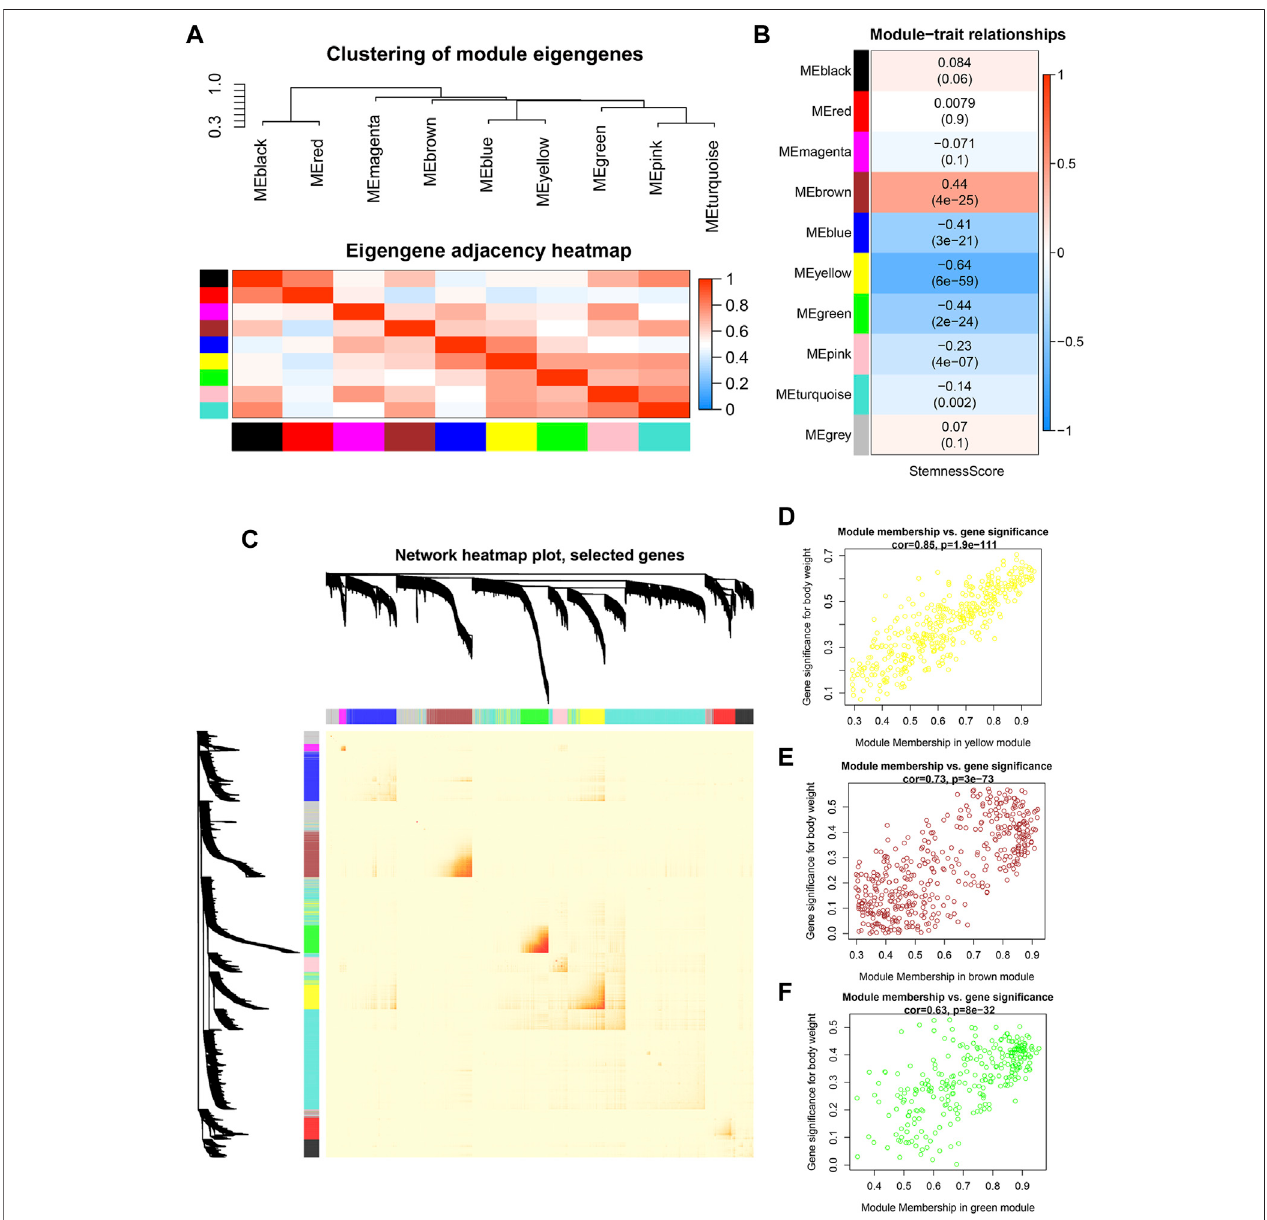
FIGURE 3 | Identi fi cation of modules signi fi cantly correlated to stemness (A) Heatmap of the adjacencies in the hub gene network. (B) Heatmap of the correlation betweenmoduleeigengenesandthestemnessscore. (C) Interactionrelationshipofco-expressiongenes. (D – F) Scatterplotofmoduleeigengenesinyellow,brownand green